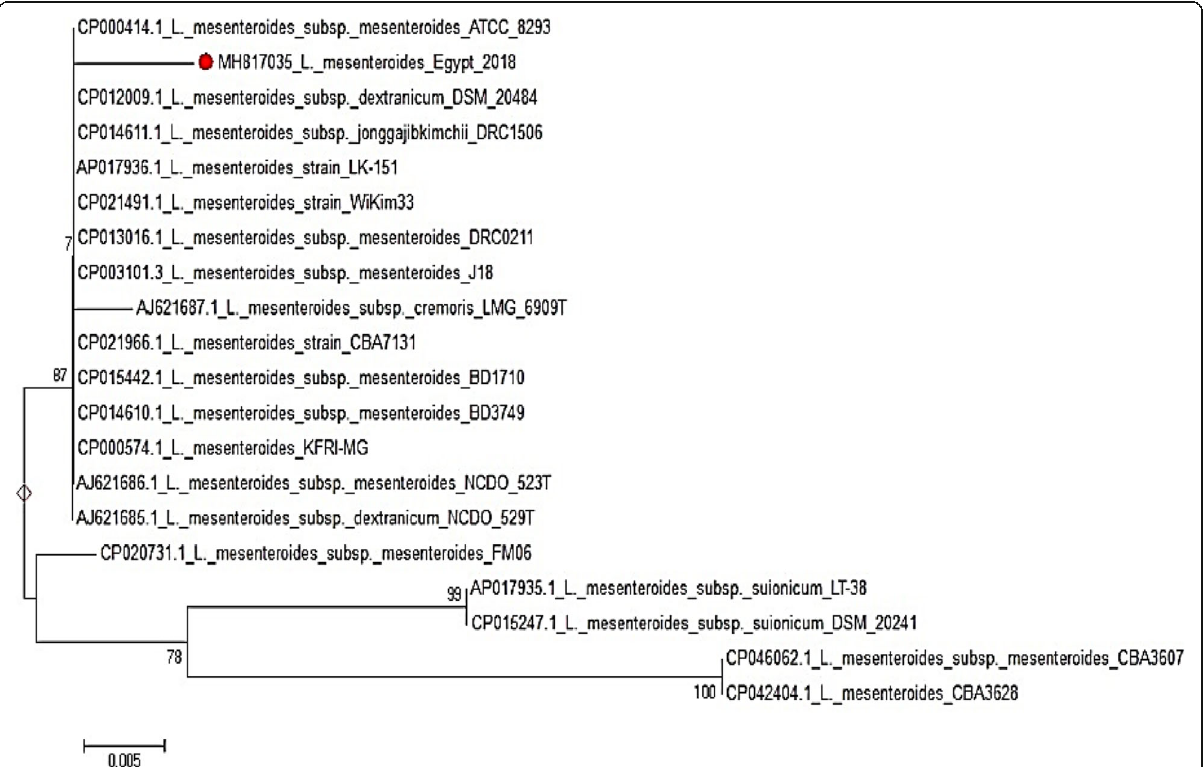
Fig. 4 Phylogenetic tree showing the phylogenetic placement of Lc . mesenteroides Egypt 2018(MH817035) as inferred by the neighbor-joining method based on recA gene sequence analyses. Bootstrap values of 1000 replicates are given